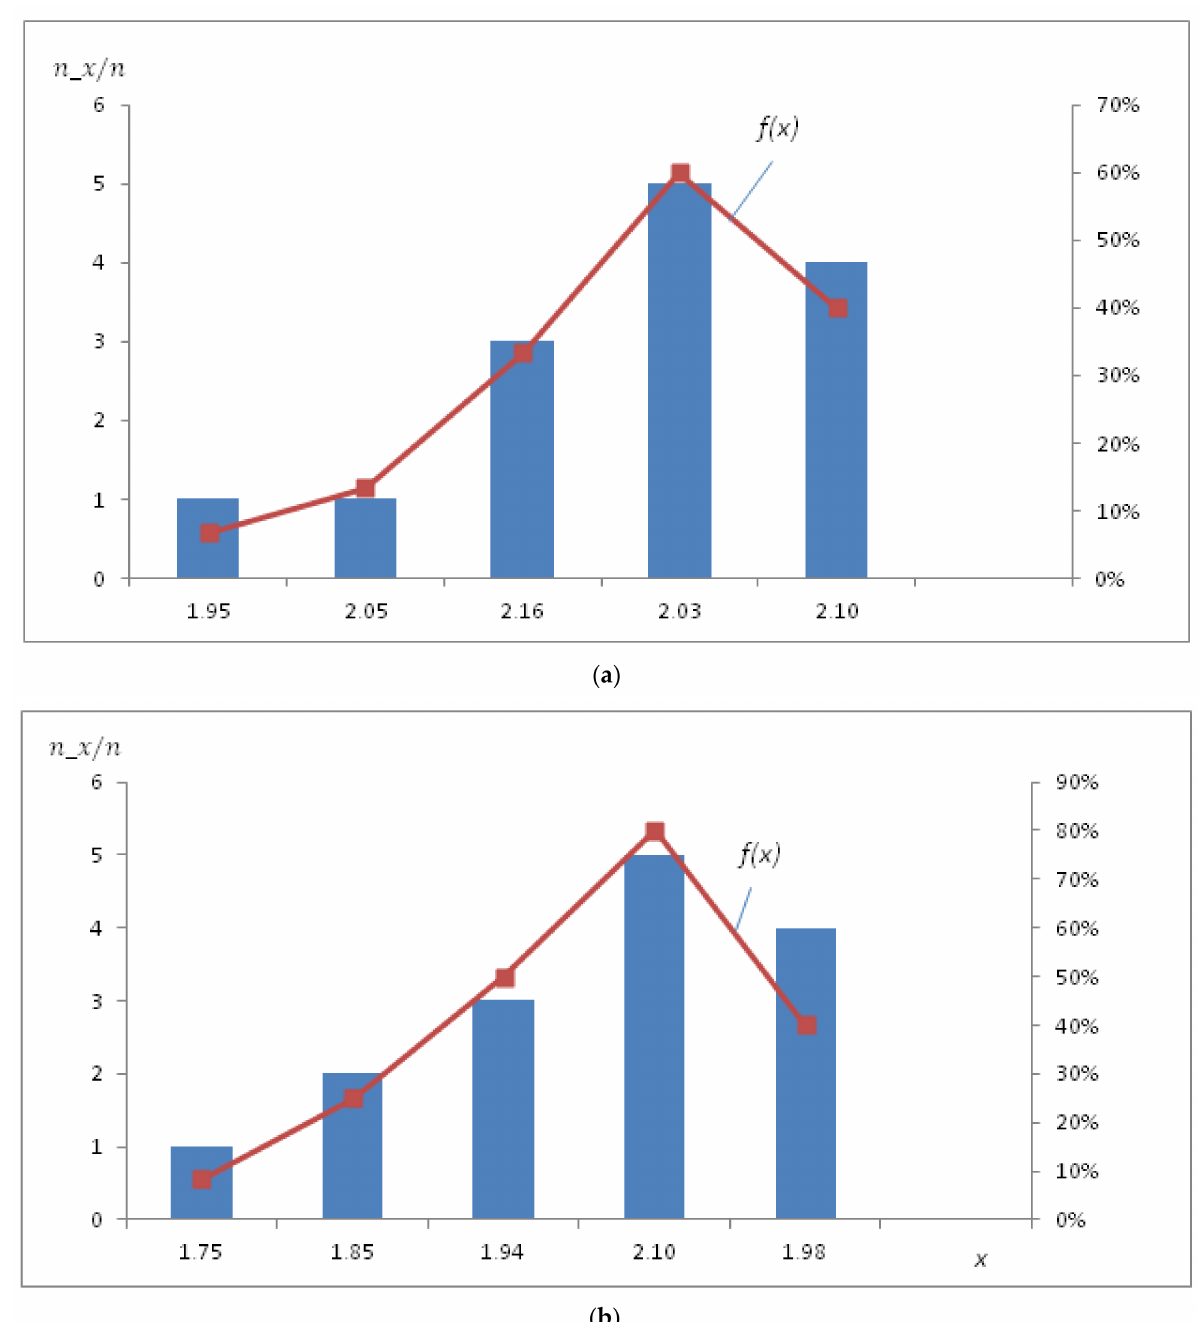
Figure 13. The histogram and the equalizing density of the distribution of the obtained values during the analytical calculation and experiment (the values in the sample are the steam velocities): ( a ) processing of the sample data in the analytical calculation, ( b ) processing of the sample data of the